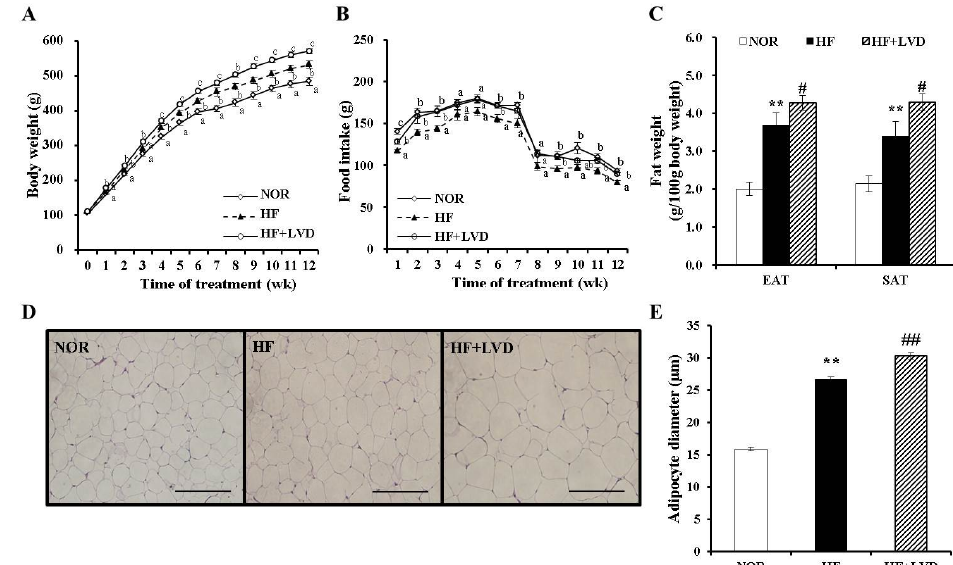
Figure 1. Effects of vitamin D ‐ insufficient diet on body weight gain and fat weight in obese rats. Body weight gain ( A ), food intake ( B ) and weight of epididymal adipose tissue (EAT) and subcutaneous adipose tissue (SAT) ( C ). Representative hematoxylin and eosin stained EAT section (scale bar, 50 μ m; magnification, 40×) ( D ). Average adipocyte diameter of adipocytes within adipose tissue ( E ) and data is expressed as the mean ± SEM. Bars with different letters (a, b, c) show significant difference ( p < 0.05). * p < 0.05; ** p < 0.01 compared to NOR. # p < 0.05; ## p < 0.01 compared to HF. NOR, 10% fat diet with 1000 IU vitamin D ( n = 9); HF, 45% fat diet with 1000 IU vitamin D ( n = 7); HF+LVD, 45% fat diet containing 25 IU vitamin D ( n = 7).